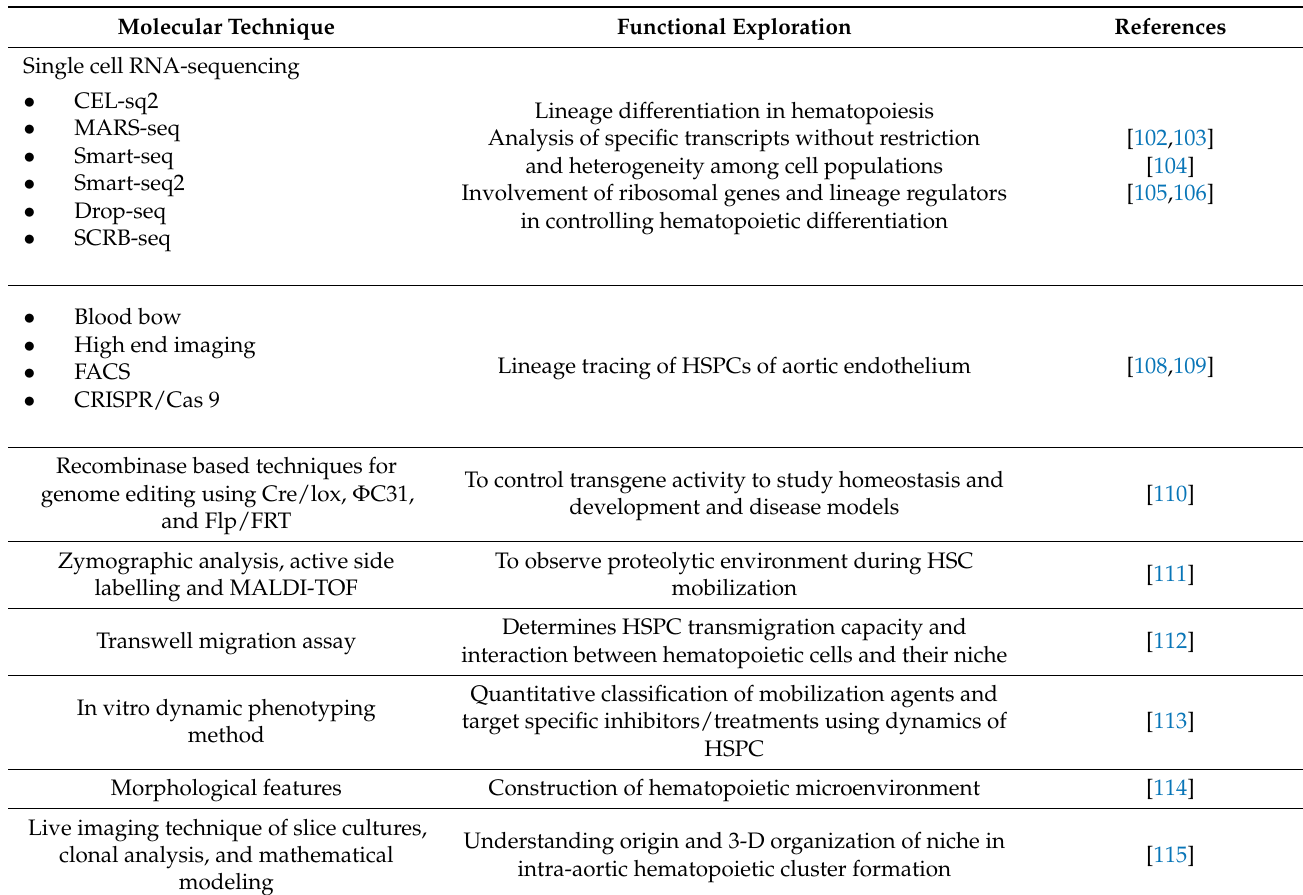
Table 1. Recent molecular approaches employed for functional